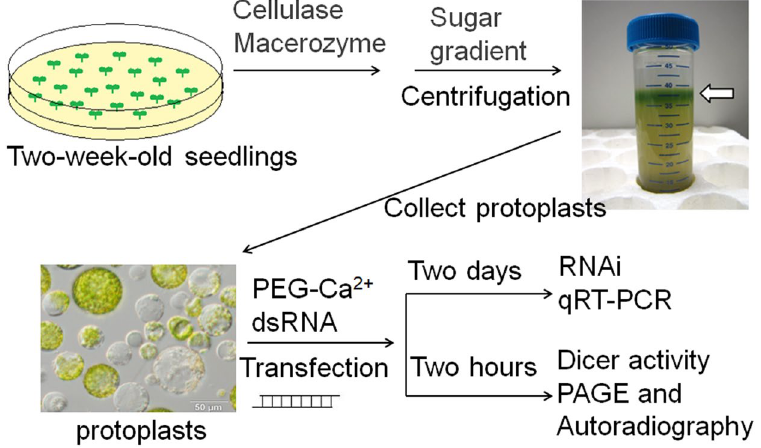
Figure 1. Schematic representation of the experimental procedure to examine the efficacies of various dsRNAs for inducing RNAi. Various dsRNAs were directly transferred into protoplasts prepared from 2-week-old Arabidopsis seedlings, and then their efficacies for inducing RNAi were analysed using qRT-PCR. DCL3 and DCL4 activities were analysed by denaturing PAGE and autoradiography. For details see Methods 28,29